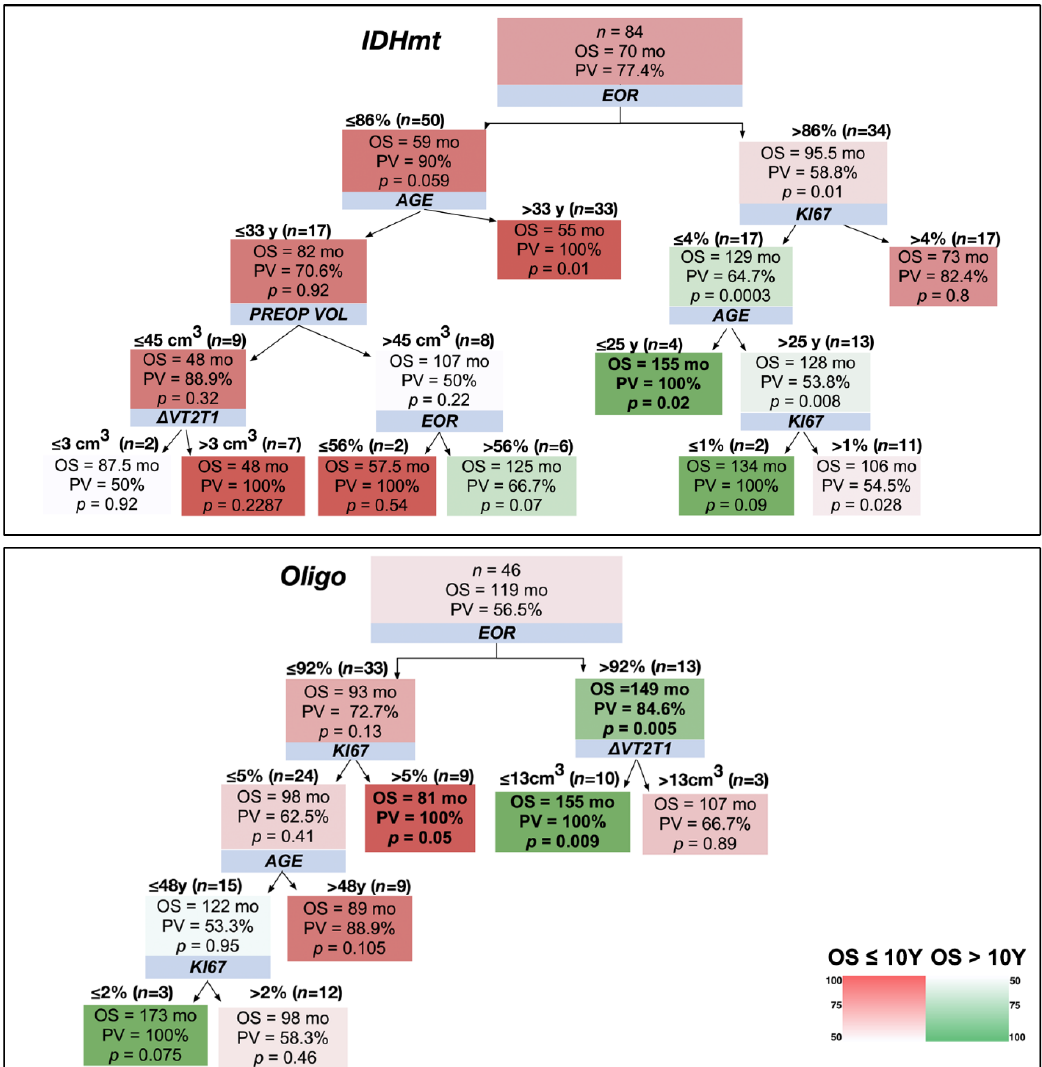
Figure 5. Decision trees applied to the three LGG molecular classes considering 10-year OS as a cut-off. The shading color of the cells indicates the predictive value (PV) of an OS superior (green) or inferior (red) to 10 years (see color heat map). Blue boxes show the variables stratifying the population. On top of the detected subgroups are shown the cut-off values and the number of patients satisfying them. Within the branches, boxes show: the median OS of the patient subgroup, the PV, and the results of the box). In bold are indicated the subgroups characterized by a PV > 75% and a p <